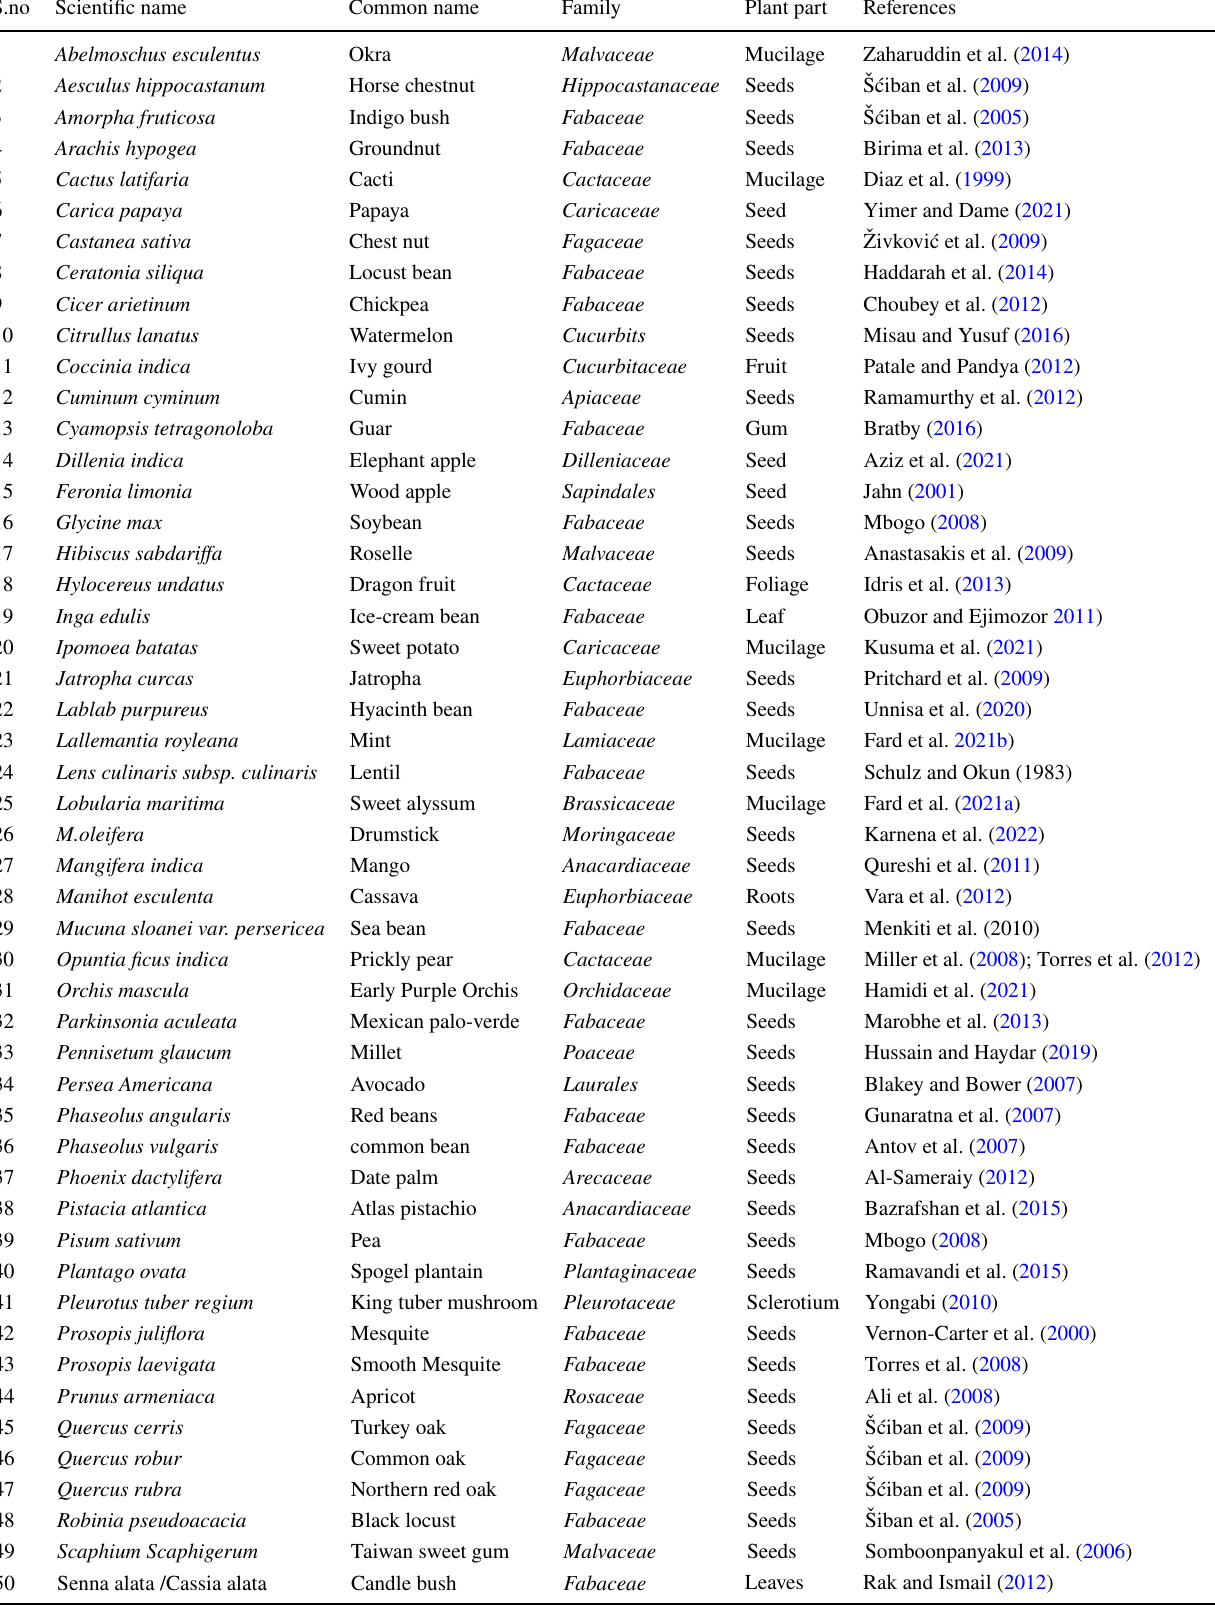
Table 1 List of prominent and identified plant-based coagulants widely explored for water treatment